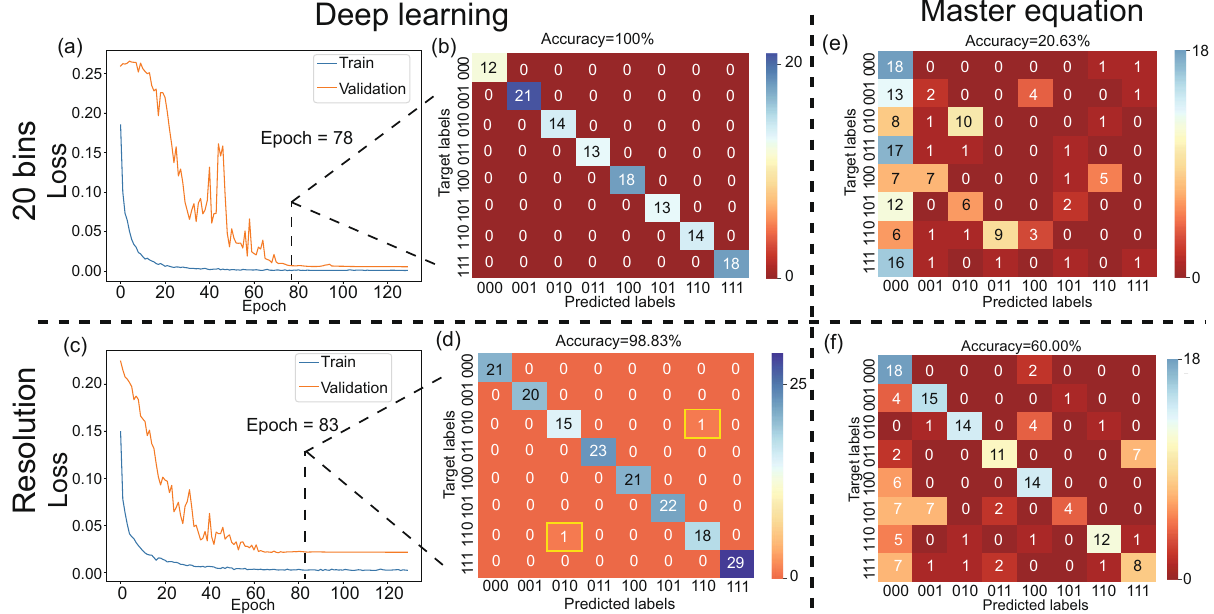
Fig. 5 Loss curves and confusion maps of the deep learning method and the master equation fi tting method for MWs with 20 bins and frequency difference Δ f . a Loss vs. epoch curves for training and validation of a 20-bin carrier with frequency difference Δ f = 2 kHz. b Confusion matrix for epoch = 78 on the test data set. Only the fi rst 3 bits of the 20 bits are selected to carry the messages and all other bits are 0. The accuracy is 100% for 123 testing spectra. c Loss vs. epoch curves for training and validation of the four MW bins (one bin is the reference) with frequency difference Δ f = 200 kHz. d Confusion matrix for epoch = 83 on the test data set. The accuracy is 98.83% for 171 testing spectra. e Predicted solution of the master equation without consideration of higher-order terms and noise on a 20-bin carrier with frequency difference Δ f = 2 kHz. The number of spectra is 160, where the spectra were sampled uniformly from eight categories. The accuracy is 20.63%. f Predicted solution of the master equation without consideration of higher-order terms and noise on four-bin carrier with frequency difference Δ f = 200 kHz. The number of spectra is 160, which were sampled uniformly from eight categories. The accuracy is 60.00%. In ( b ) and ( e ), only the fi rst 3 bits of a total of 20 bits (including a reference) are